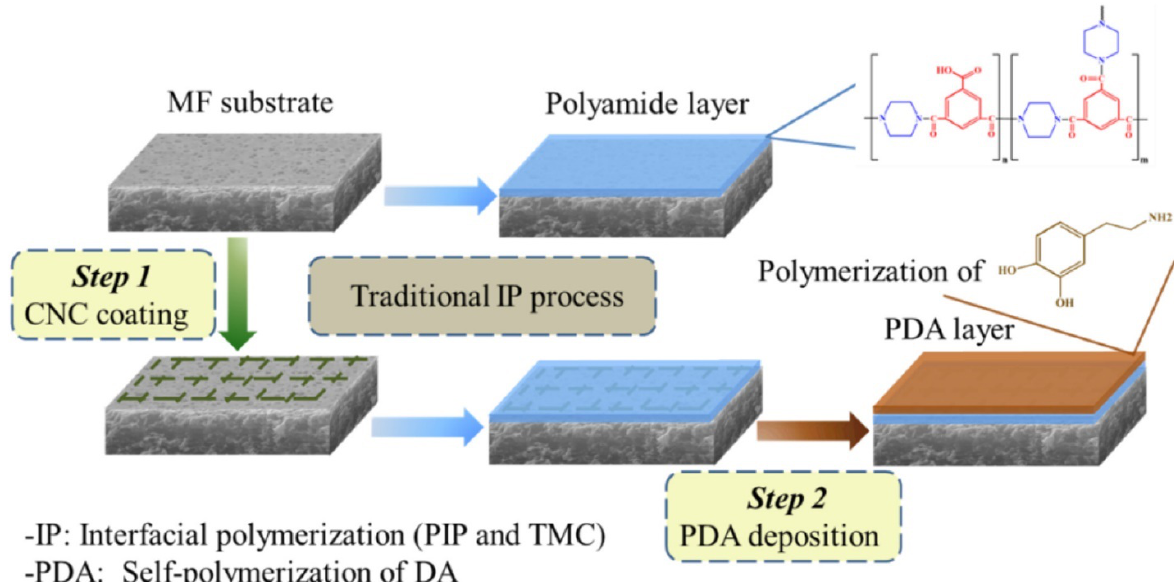
Figure 7. Diagrammatic representation of the CNC-TFC-PDA membrane preparation. Re- Figure 5. Diagrammatic representation of the CNC-TFC-PDA membrane preparation. Reprinted with printed/adapted with permission from [91]. permission from Ref. [92]. Copyright 2020 Elsevier B.V. All rights